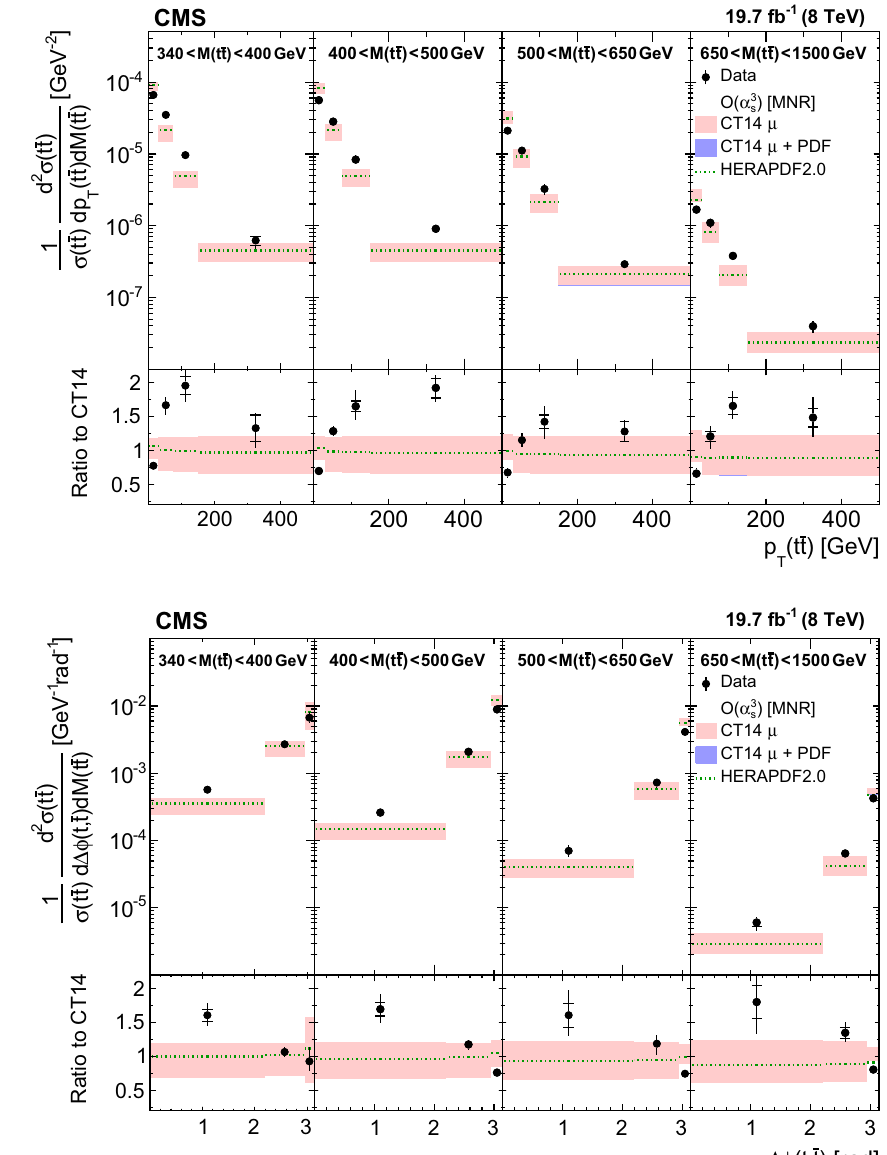
Fig. 12 Comparison of the measured normalized tt double-differential cross section as a function of p T ( tt ) in different M ( tt ) ranges to NLO O (α 3 s ) predictions. Details can be found in the caption of Fig. 8. Approximate NNLO O (α 4 s ) predictions are not available for this cross section